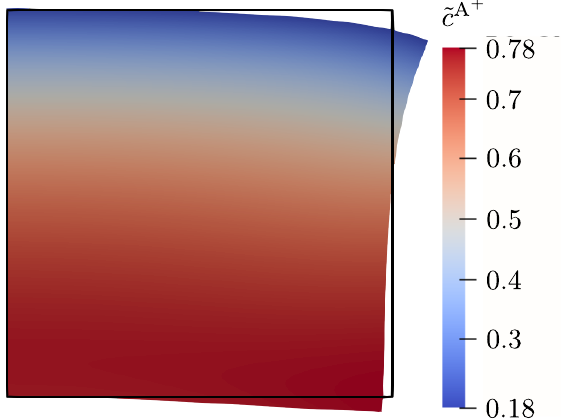
Figure 6. Deformed shape of the hydrogel cylinder at time ˜ t e together with cation concentration ˜ c A + and outline of the undeformed shape (result obtained with m t = 2 and m h =